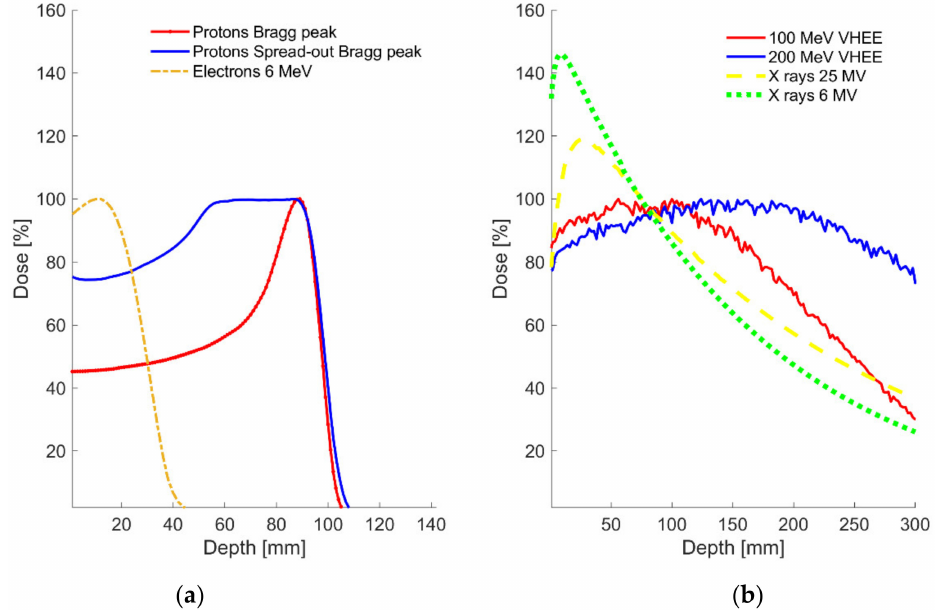
Figure 1. Comparison of relative depth dose distributions of photons, protons, and electrons, and VHEEs in case of a single field: ( a ) 110 MeV protons Bragg peak or SOBP and 6 MeV electrons in water, ( b ) 25 and 6 MV X-rays, 100 and 200 MeV VHEE in water (Monte Carlo